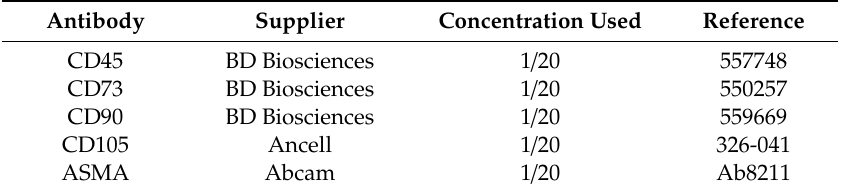
Table 2. Antibodies used for flow cytometry analyses of adult-derived human liver stem / progenitor cells